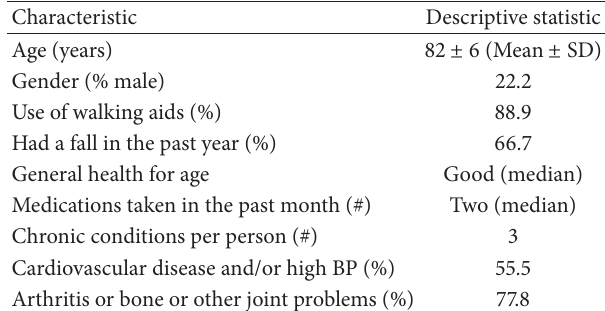
Table 1: Participant